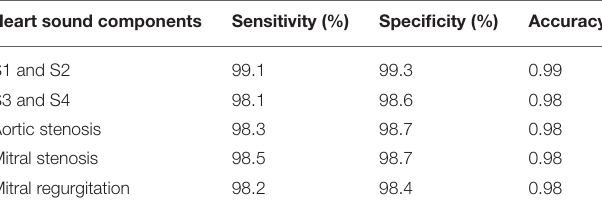
TABLE 2 | Accuracy of proposed system for different cardiac components in heart sounds. Heart sound components Sensitivity (%) Specificity (%) Accuracy